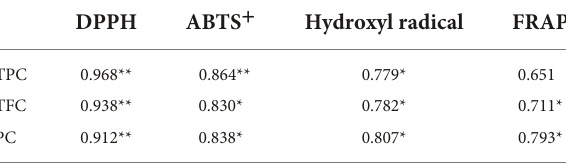
TABLE 1 Pearson’s correlation coefficients among total phenolic content (TPC), total flavone content (TFC), proanthocyanidin content (PC), and antioxidant